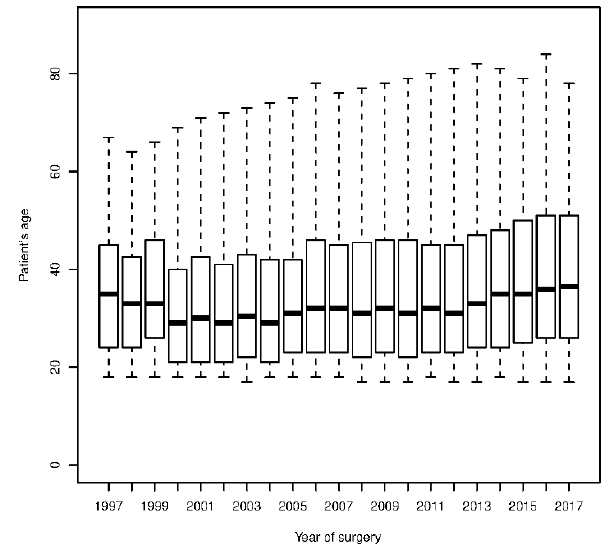
Figure 1. Boxplot showing variation of patients’ age at surgery during the last two decades. Results are shown as median age, interquartile range and overall interval.